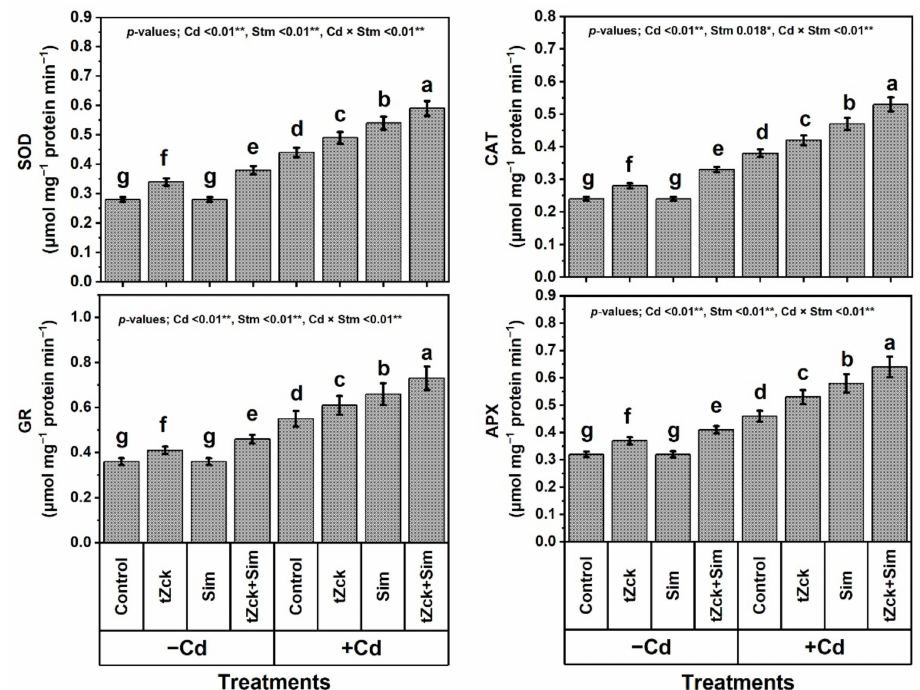
Figure 8. Enzyme activities of wheat (cv. Sakha 93) treated with two stimulators (Stm) i.e., silymarin (Sim; 0.5 mM) and trans -zeatin-type cytokinin ( t Zck; 0.05 mM) under cadmium (Cd; 0.6 mM) stress. The same letters with mean values ± SE in each plot indicate non-significant differences based on the LSD test ( p ≤ 0.05). SOD, superoxide dismutase; CAT, catalase; APX, ascorbate peroxidase; and GR, glutathione reductase. * and ** refer to significant difference at p ≤ 0.05 and p ≤ 0.01, respectively. t Zck; trans -zeatin-type cytokinin, Sim; silymarin, − Cd; without cadmium treatment, +Cd; cadmium treatment and Stm;